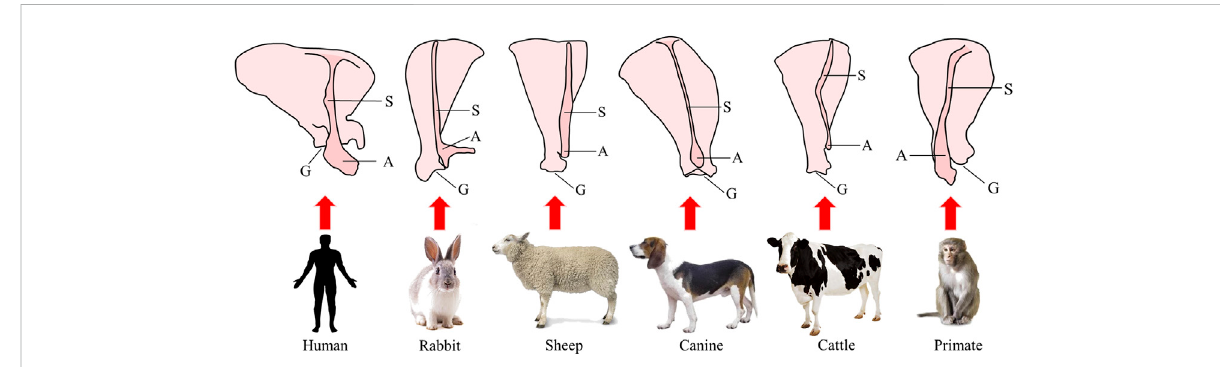
FIGURE 2 Schematic diagram of the structure of the scapula in humans and different animals. S, scapular spine; A, acromion; G, glenoid